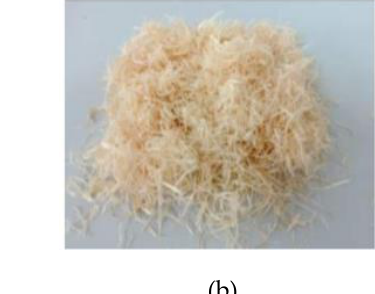
Figure 6. Schematic of experimental setup.